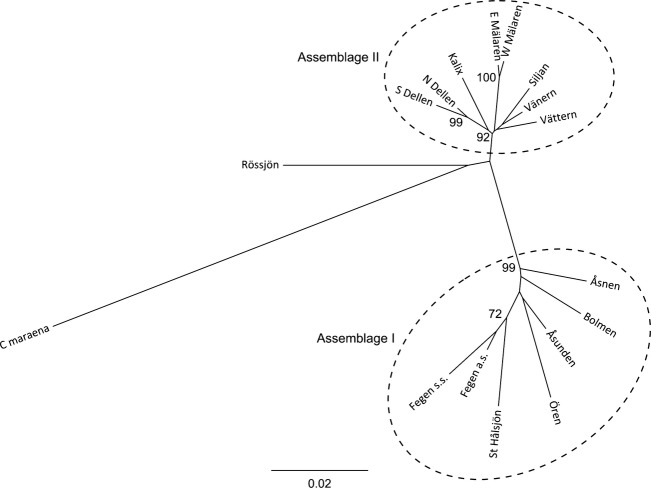
Unrooted neighbor-joining tree based on nine nuclear microsatellites and pairwise chord distances among 16 Baltic cisco populations and one sample of whitefish (C. maraena). Numbers are percentage node support values following 1000 bootstraps (only values >70% included).